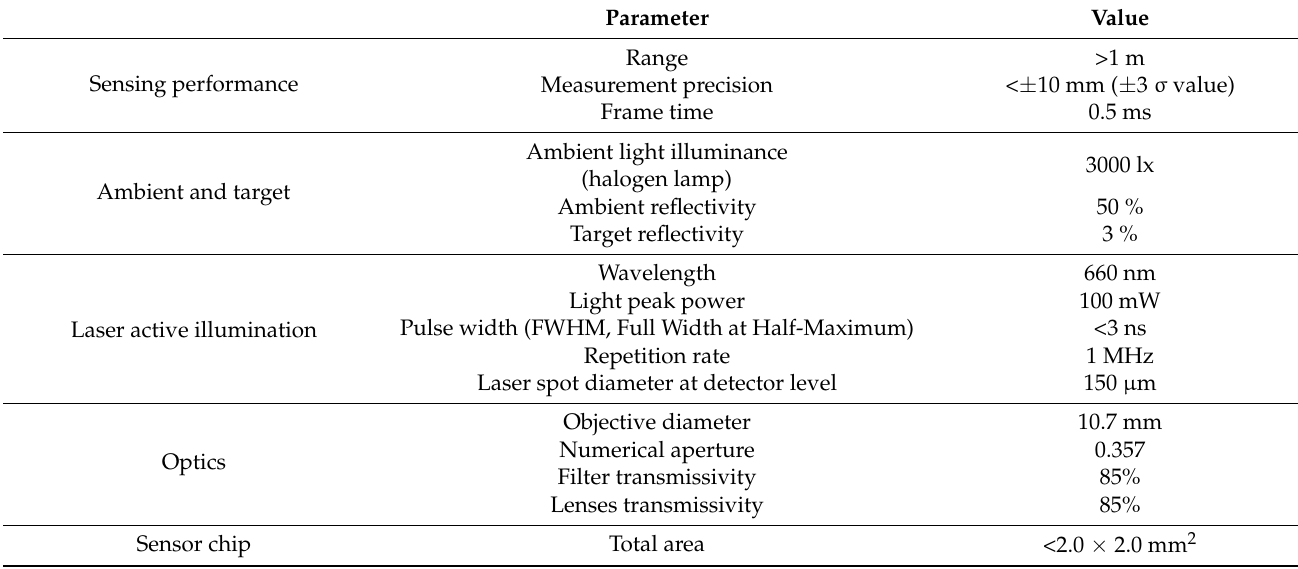
Table 2. Specifications and performance requirements for the single-point TOF sensor. Parameter Value Sensing